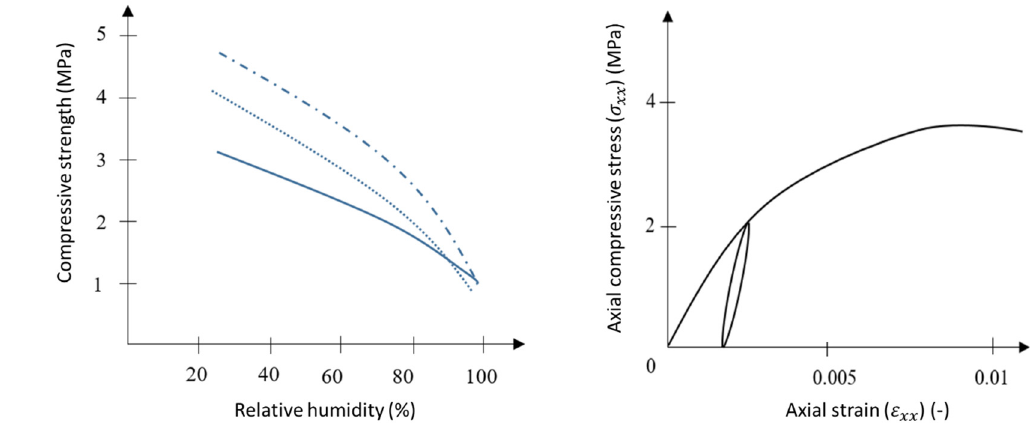
Figure 2. (a) Sharp decrease of compressive strength with Relative Humidity for 3 different earths used in vernacular rammed earth architecture; (b) Typical stress‐strain behaviour of earth during a compression test on cylindrical specimen of aspect ratio of 2, vertical axis x, with one cycle at 2 MPa with strain measured locally; from